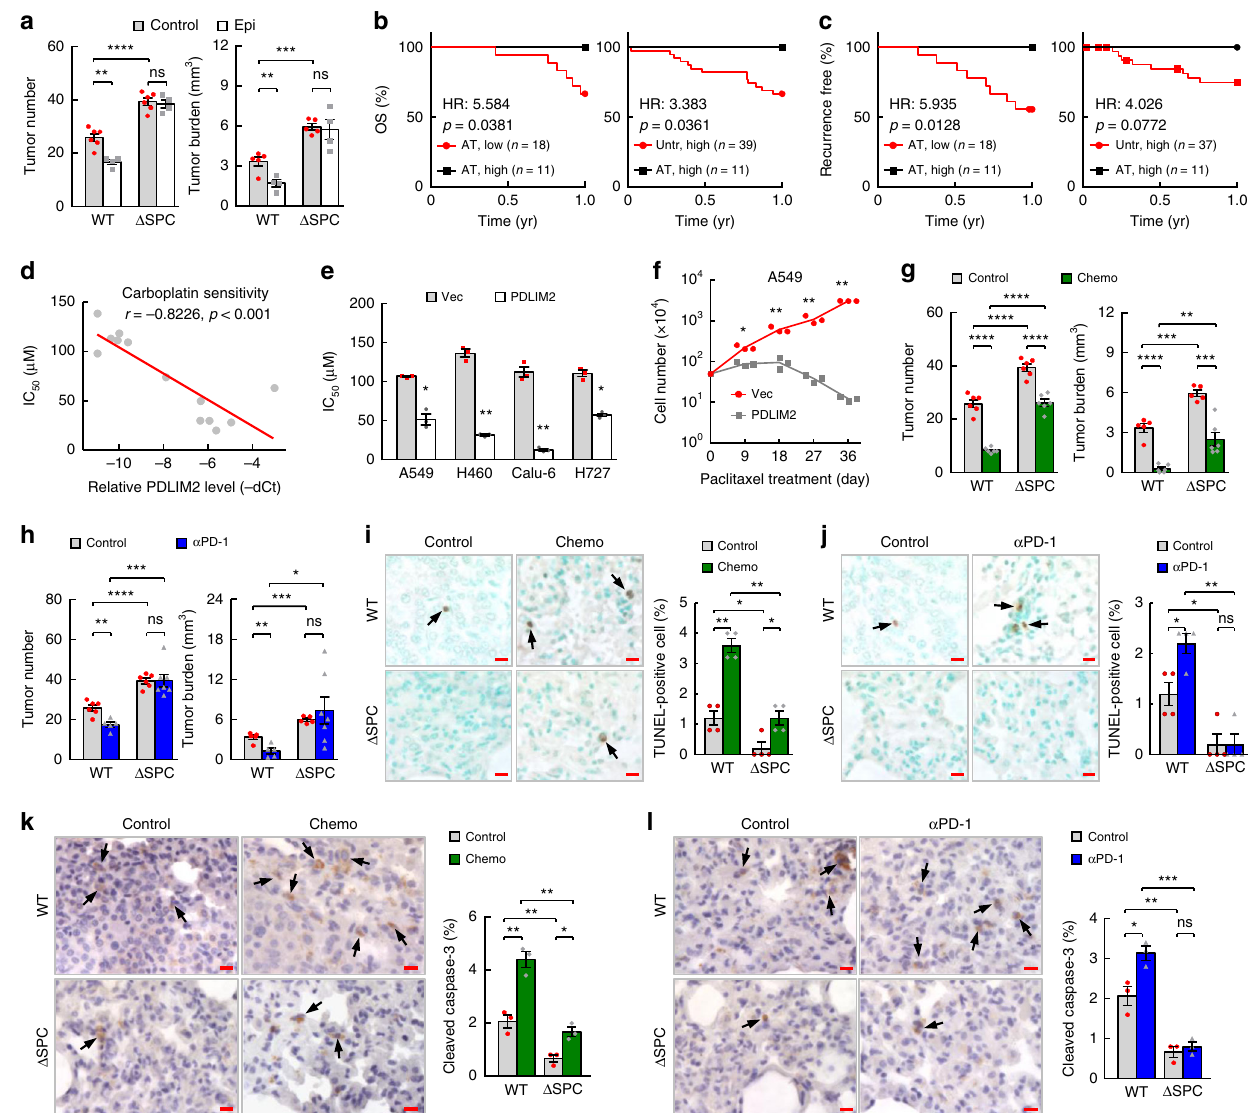
Fig. 4 PDLIM2 is critical for lung cancer therapeutic responses. a Urethane model showing complete resistance to epigenetic therapy of lung cancer in Δ SPC mice ( n ≥ 4). b , c Kaplan – Meier survival curve on human lung tumor data (GSE37745) showing better overall survival (OS, b ) and recurrence-free survival ( c ) of patients with high PDLIM2 expression and received adjuvant treatment (AT), compared to that of patients with low PDLIM2 expression and received AT, or that of patients with high PDLIM2 expression but did not receive AT (Untr). Log-rank test was performed. d , e In vitro IC 50 assay showing negative association between PDLIM2 expression and carboplatin sensitivity in lung cancer ( d ), and increased carboplatin sensitivity by PDLIM2 reconstitution ( e ) ( n = 3). Pearson ’ s correlation test was performed in ( d ). f Cell growth assays showing increased paclitaxel sensitivity of A549 lung cancer cells by PDLIM2 reconstitution. Cells were treated with paclitaxel as shown in Supplementary Fig. 4a. g Urethane model showing increased carboplatin-paclitaxel chemo-resistance of lung cancer in Δ SPC mice ( n ≥ 5). h Urethane model showing complete anti-PD-1 resistance of lung cancer in Δ SPC mice ( n ≥ 5). i – l TUNEL assay ( i , j ) and IHC staining of cleaved caspase-3 ( k , l ) showing decrease in both basal and induced cancer cell apoptosis in